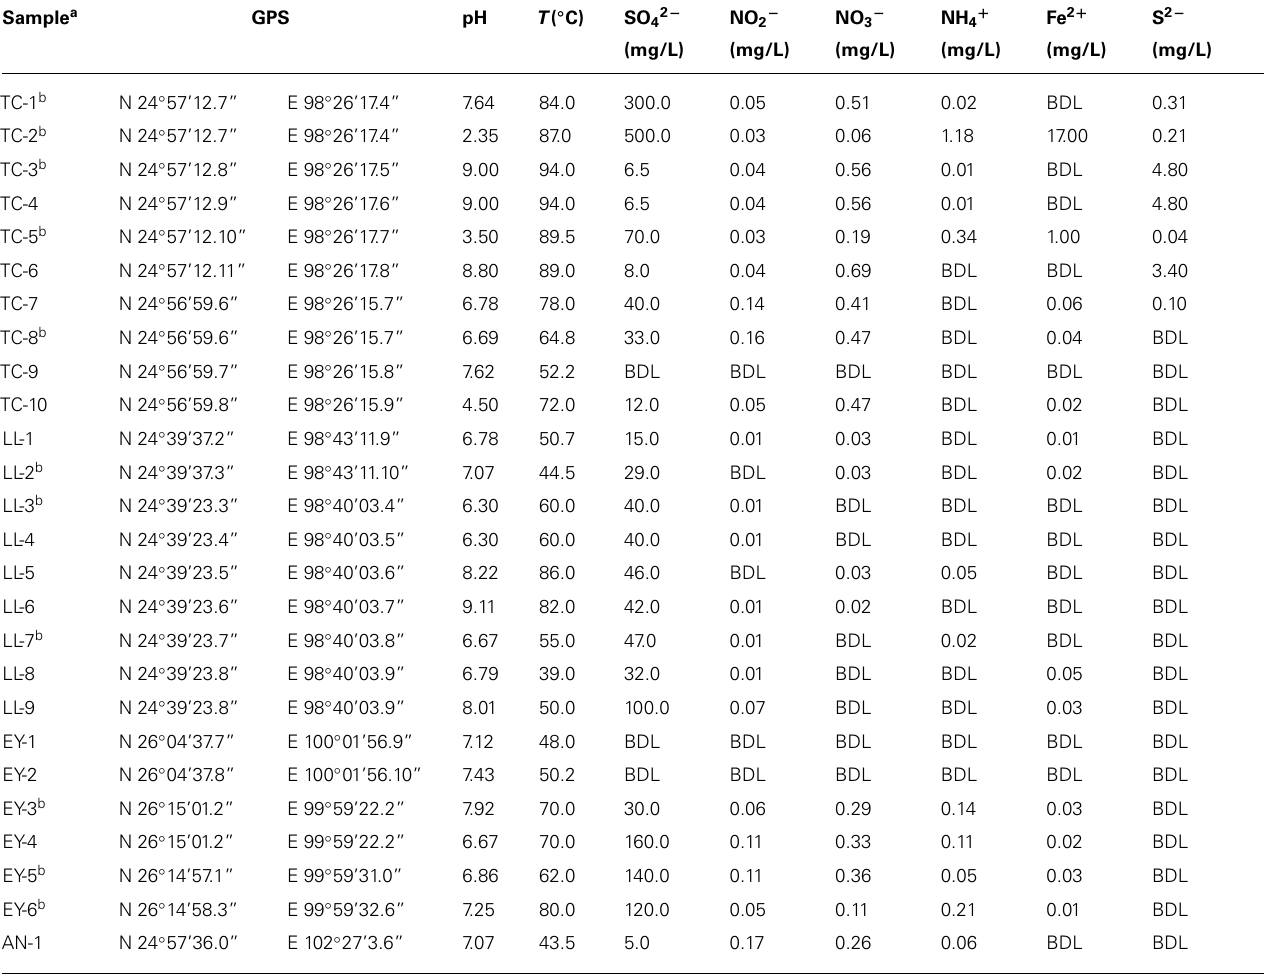
Table 1 | Location and water chemistry ofYunnan hot